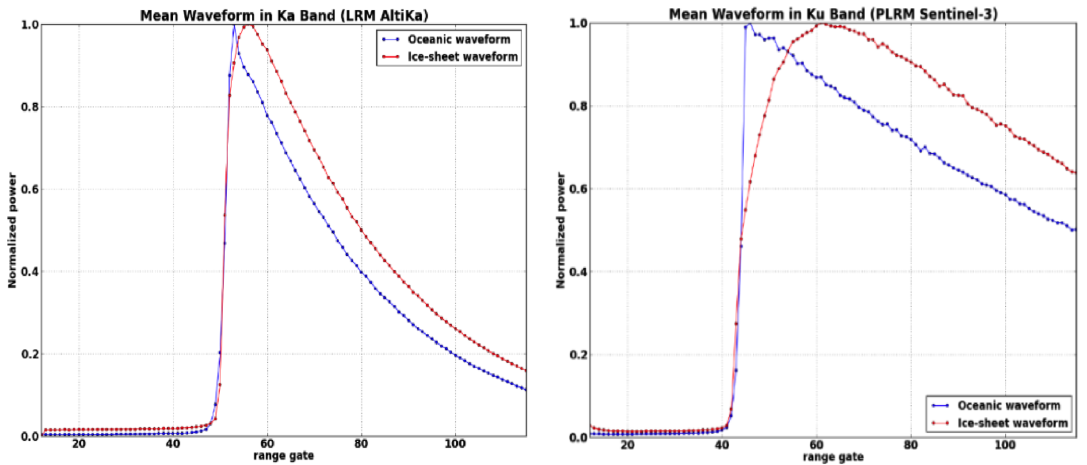
Figure 16. Mean SARAL/AltiKa ( left ) and Sentinel-3A ( right ) waveforms over ocean (blue) and Lake Vostok